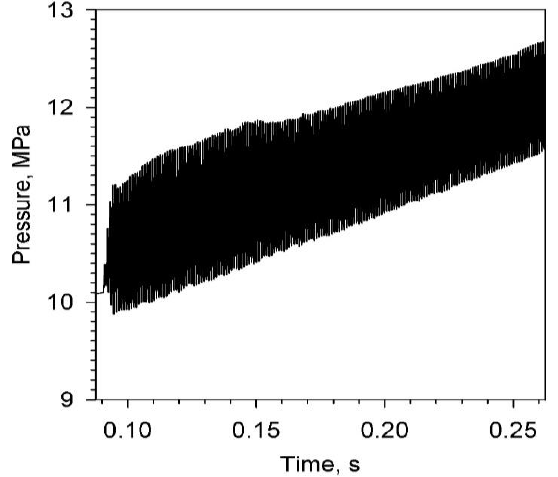
Figure 10. Predicted head-end pressure-time profile, reference motor ( K Δ H = 150,000 J/kg, α = 5%, d = 50 µm; Δ p = 2 atm), single regressing particle set s p m,o d (D 2 law, k = 3.6 × 10 −7 m 2 /s), acceleration r